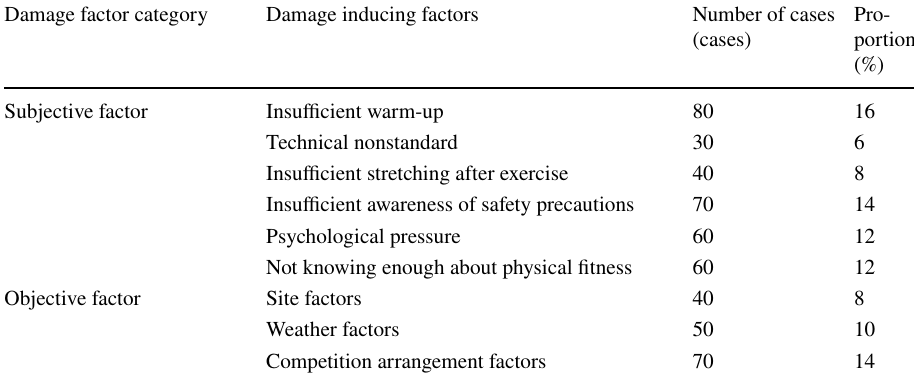
Table 1 Incentives for injuries of football